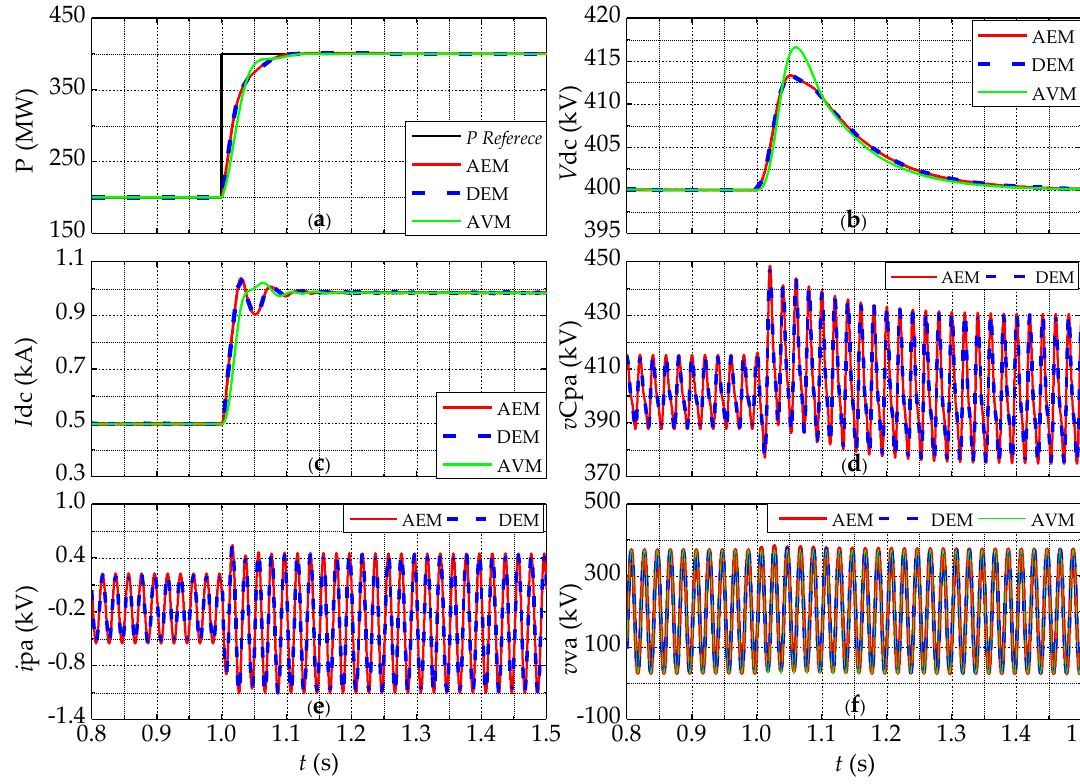
Figure 11. Steady state: ( a ) MMC1 active power; ( b ) DC voltage; ( c ) DC current; ( d ) SMs capacitor voltage; ( e ) Current in upper arm in phase a ; ( f ) AC voltage in phase a at valve-side.